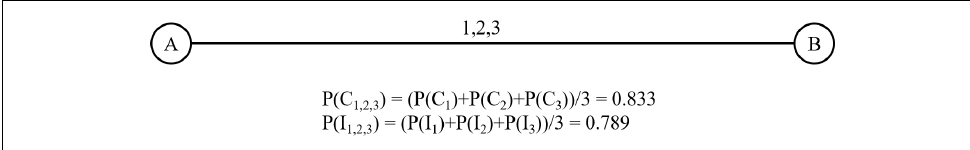
Figure 7. A Single-Channel, Point-to-Point Equivalent of a Three-Channel, Point-to-Point